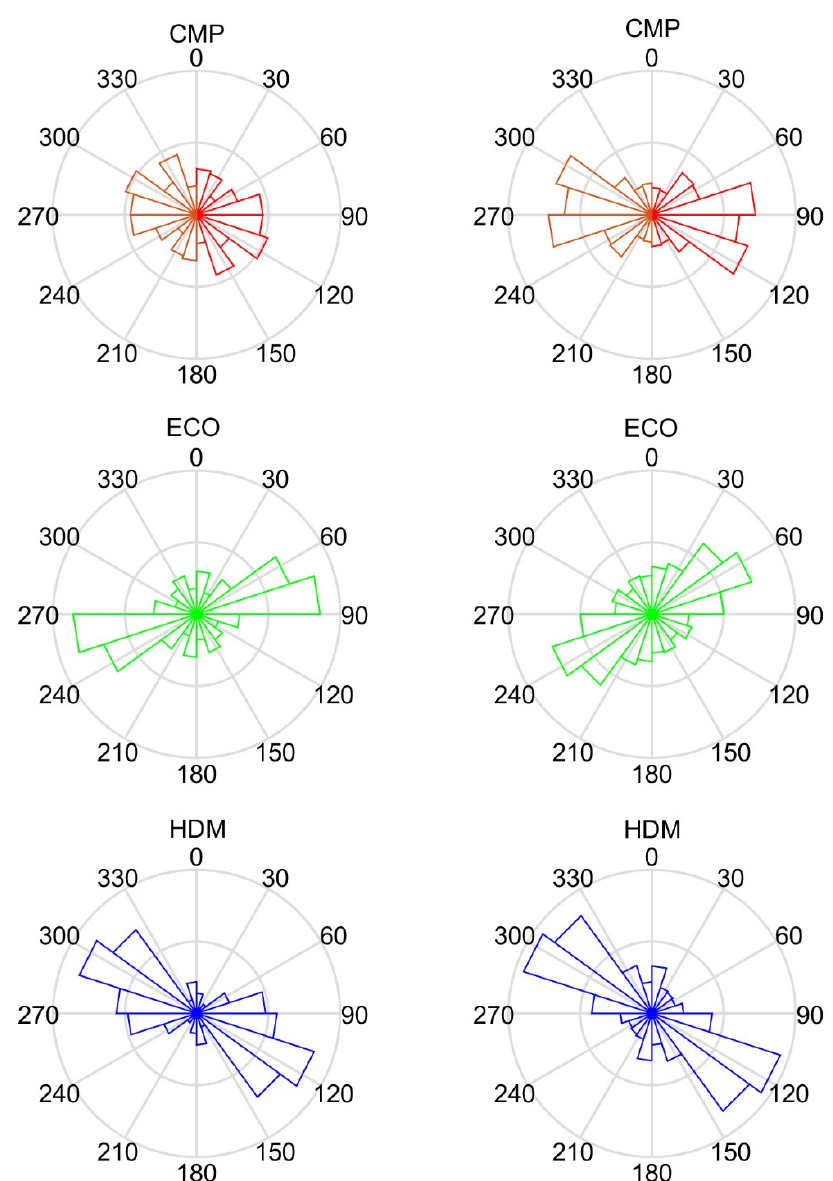
Figure 7. On the left , rose diagrams of the azimuths of the tilt signals corresponding to the Mm constituent (red = CMP, green = ECO, blue = HDM); on the right the same for the Mf constituent.